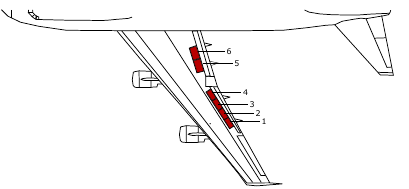
Figure 3. Assumed number and position of spoilers on a single B747